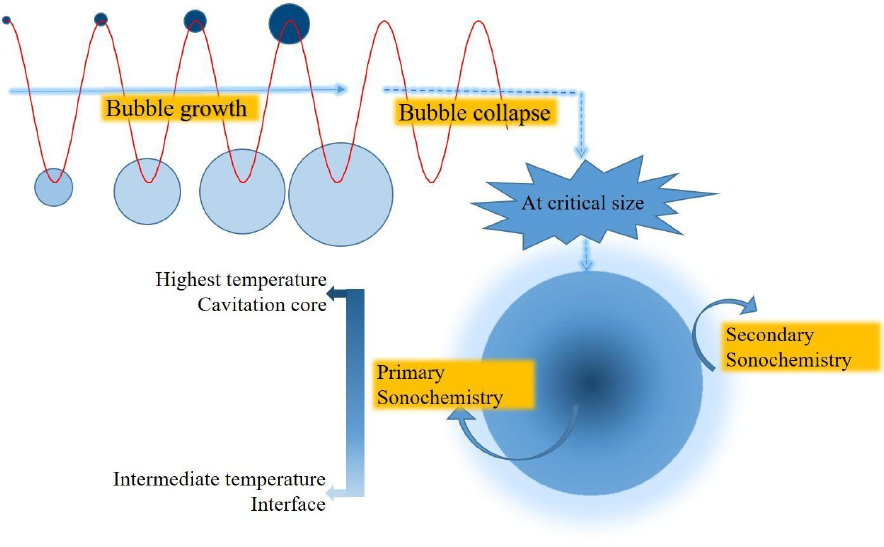
Figure 9. Reaction mechanism for sonochemical reaction.